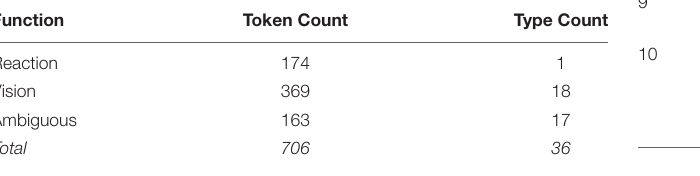
TABLE 4 | Summary of the family of “ LOOK ” signs by function, token, and type. Function Token Count Type Count Reaction 174